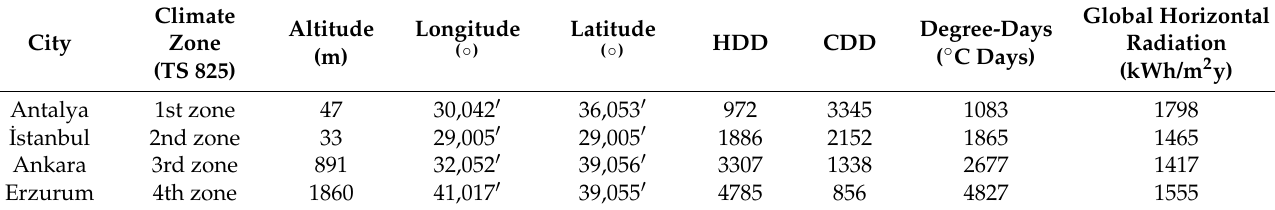
Figure 2. Four different degree-day regions of Turkey according to TS 825 regulations. The selected cities and their data are depicted in Table 2. Additionally, the energy savings and cost analysis resulting from the use of building materials and insulation were compared at a base “Maximum Allowable Annual Energy Requirement”, which were estimated individually for each region. Table 2. Data for selected cities [27,28].